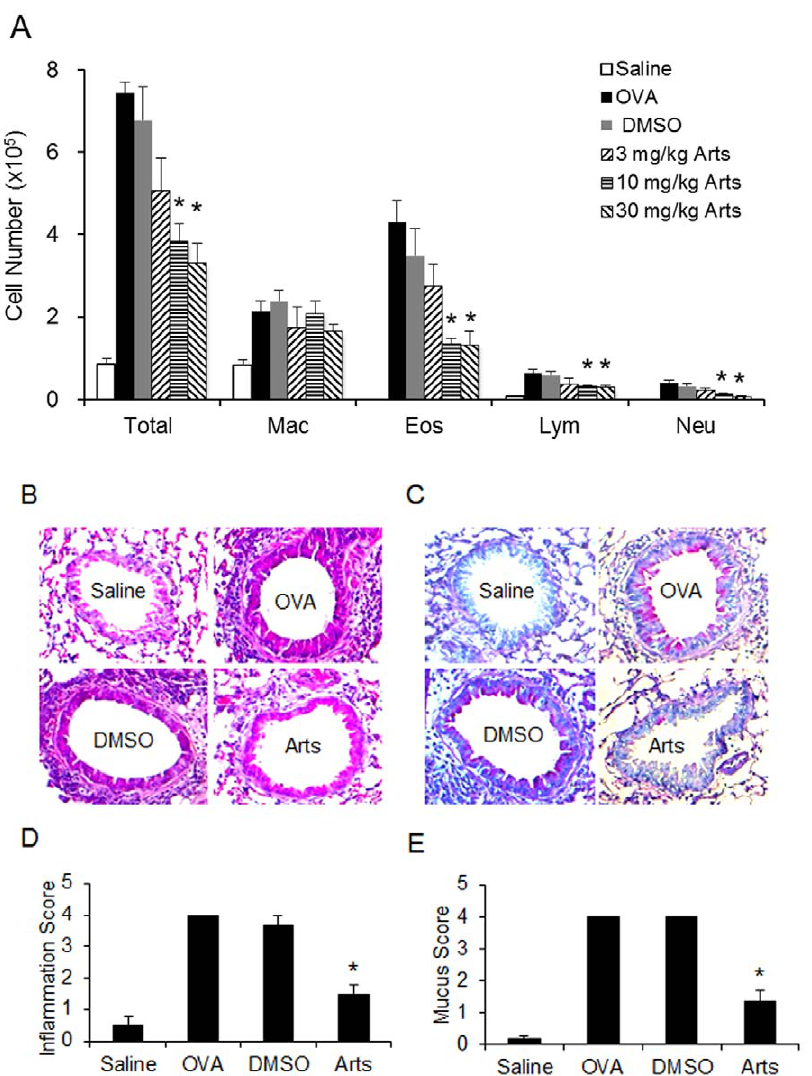
Figure 1. Effects of artesunate on OVA-induced inflammatory cell recruitment and mucus hypersecretion. (A) Inflammatory cell counts in BAL fluid obtained from sensitized mice 24 hours after the last saline aerosol (n=7 mice) or OVA aerosol (n=9 mice) challenge. Artesunate dose- dependently reduced OVA-induced inflammatory cell counts in BAL fluid from sensitized mice 24 hours after the last OVA aerosol challenge (DMSO, n=9; 3 mg/kg, n=7; 10 mg/kg, n=9; and 30 mg/kg, n=10). Differential cell counts were performed on a minimum of 500 cells to identify eosinophil (Eos), macrophage (Mac), neutrophil (Neu), and lymphocyte (Lym). Histological sections of lung tissue eosinophilia (B, magnification 6 200) and mucus secretion (C, magnification 6 200) 24 hours after the last challenge of saline aerosol, OVA aerosol, OVA aerosol plus DMSO, or OVA aerosol plus 30 mg/ kg artesunate were evaluated. Quantitative analyses of inflammatory cell infiltration (D) and mucus production (E) in lung sections were performed as previously described [56]. Scoring of inflammatory cells and goblet cells was performed in at least 3 different fields for each lung section. Mean scores were obtained from 4 animals. *Significant difference from DMSO control, p , 0.05.